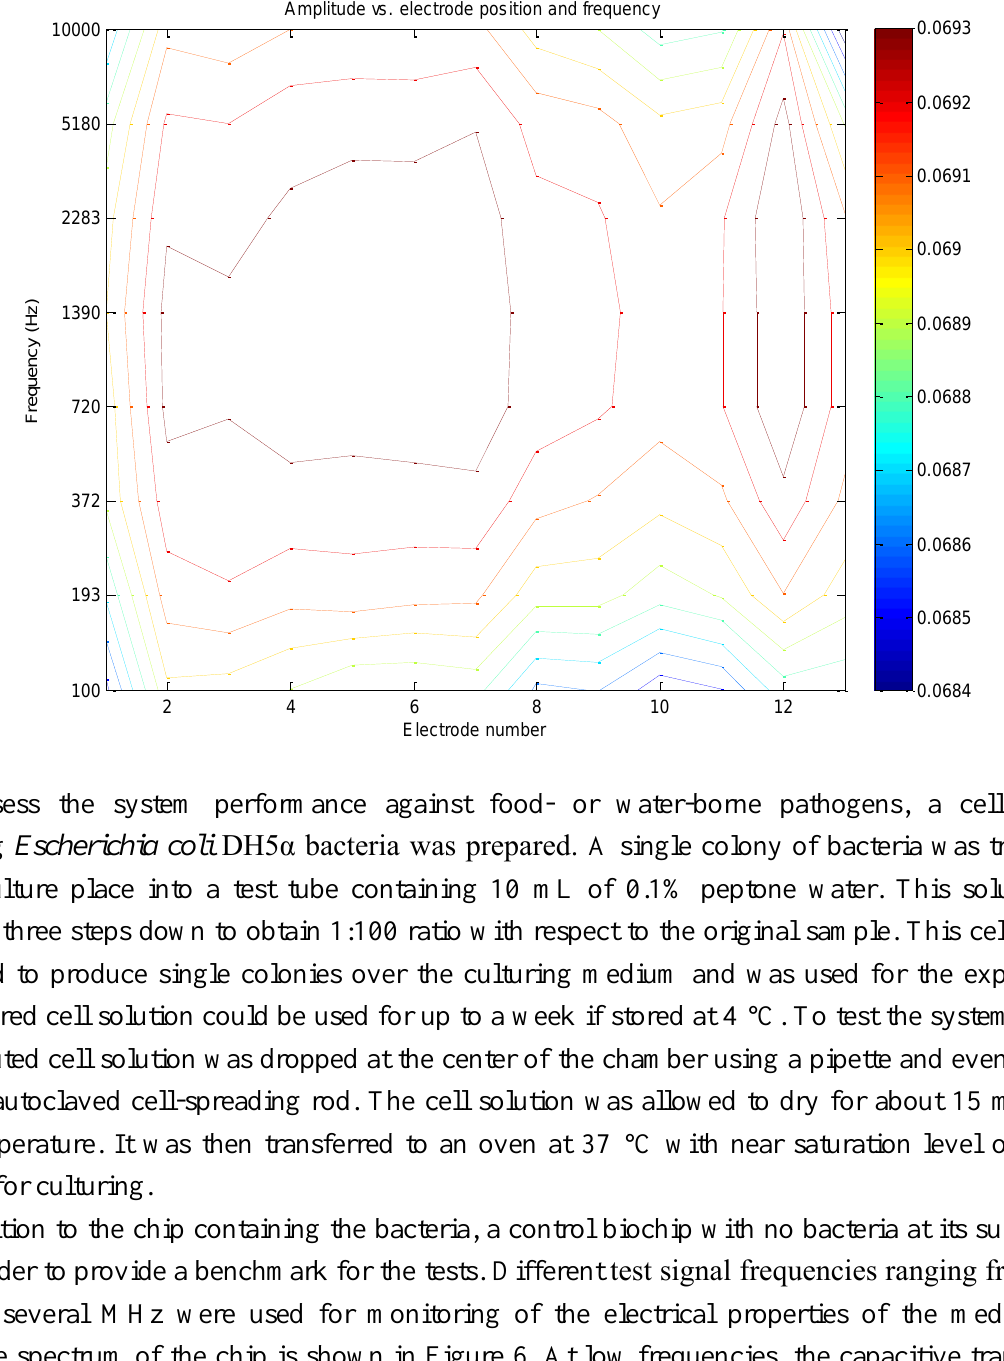
Figure 5. Contour plot indicating presence of cells at electrode pairs 2, 3, 4, 5, 6, 7 and